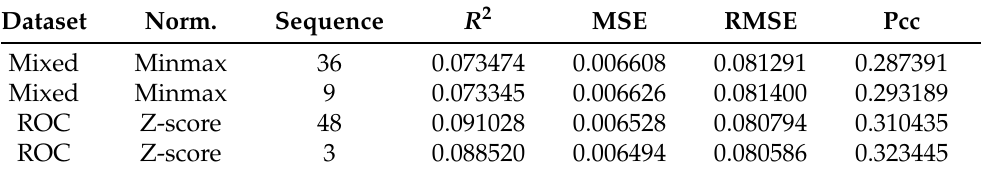
Table 9. Top 2 best metric performers in GRU